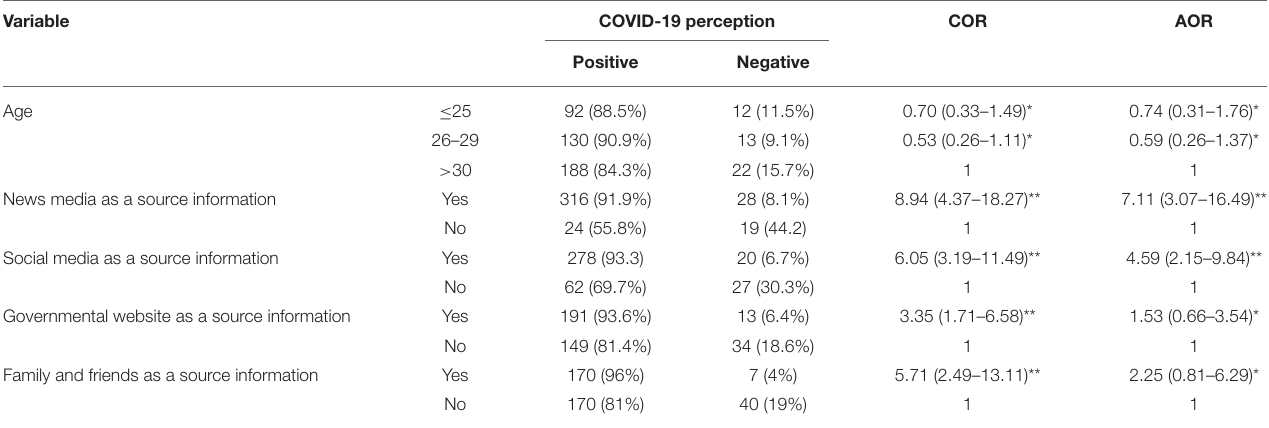
TABLE 3 | Univariate and multivariate logistic regression analyses of perception about COVID-19 among health workers at Aksum University Comprehensive and Specialized Hospital (AKUCSH) and Saint Mary’s General Hospital in Tigray Regional State of Northern Ethiopia, ( n = 403), April to May 2020.